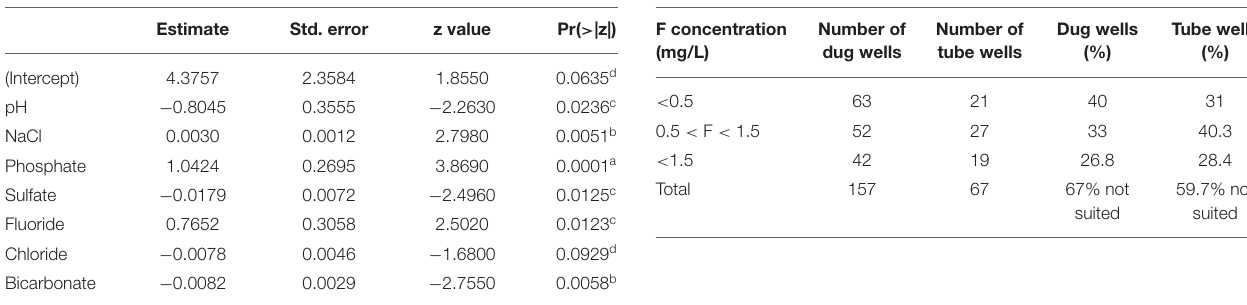
TABLE 5 | Suitability of groundwater in terms of F −